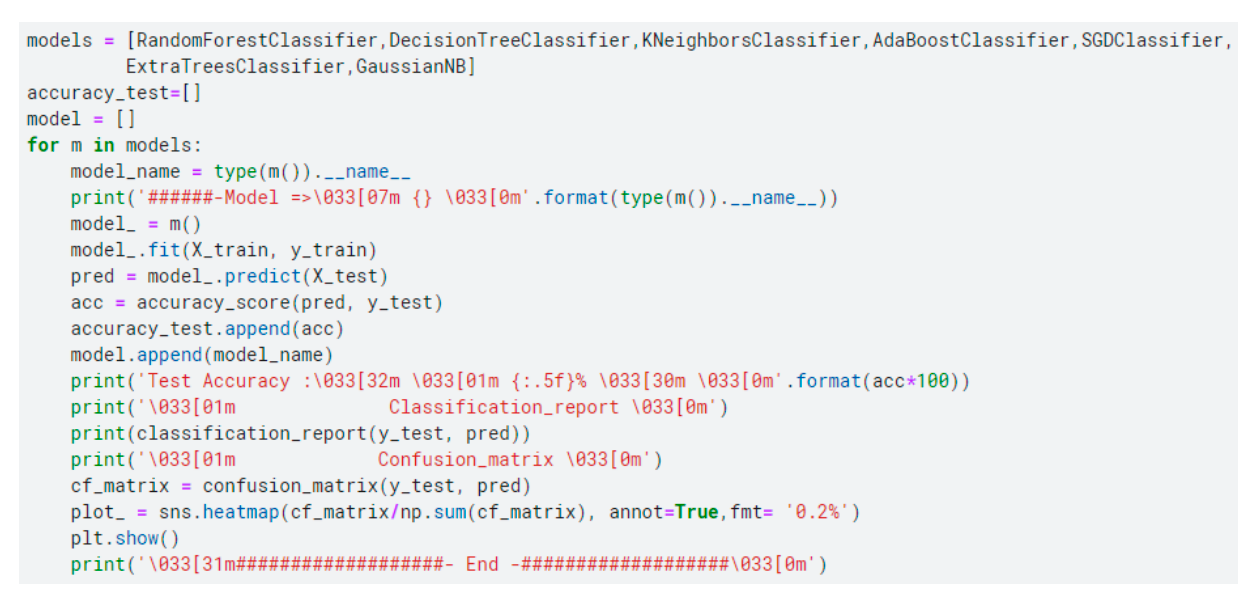
Figure A1. Testing of the models.